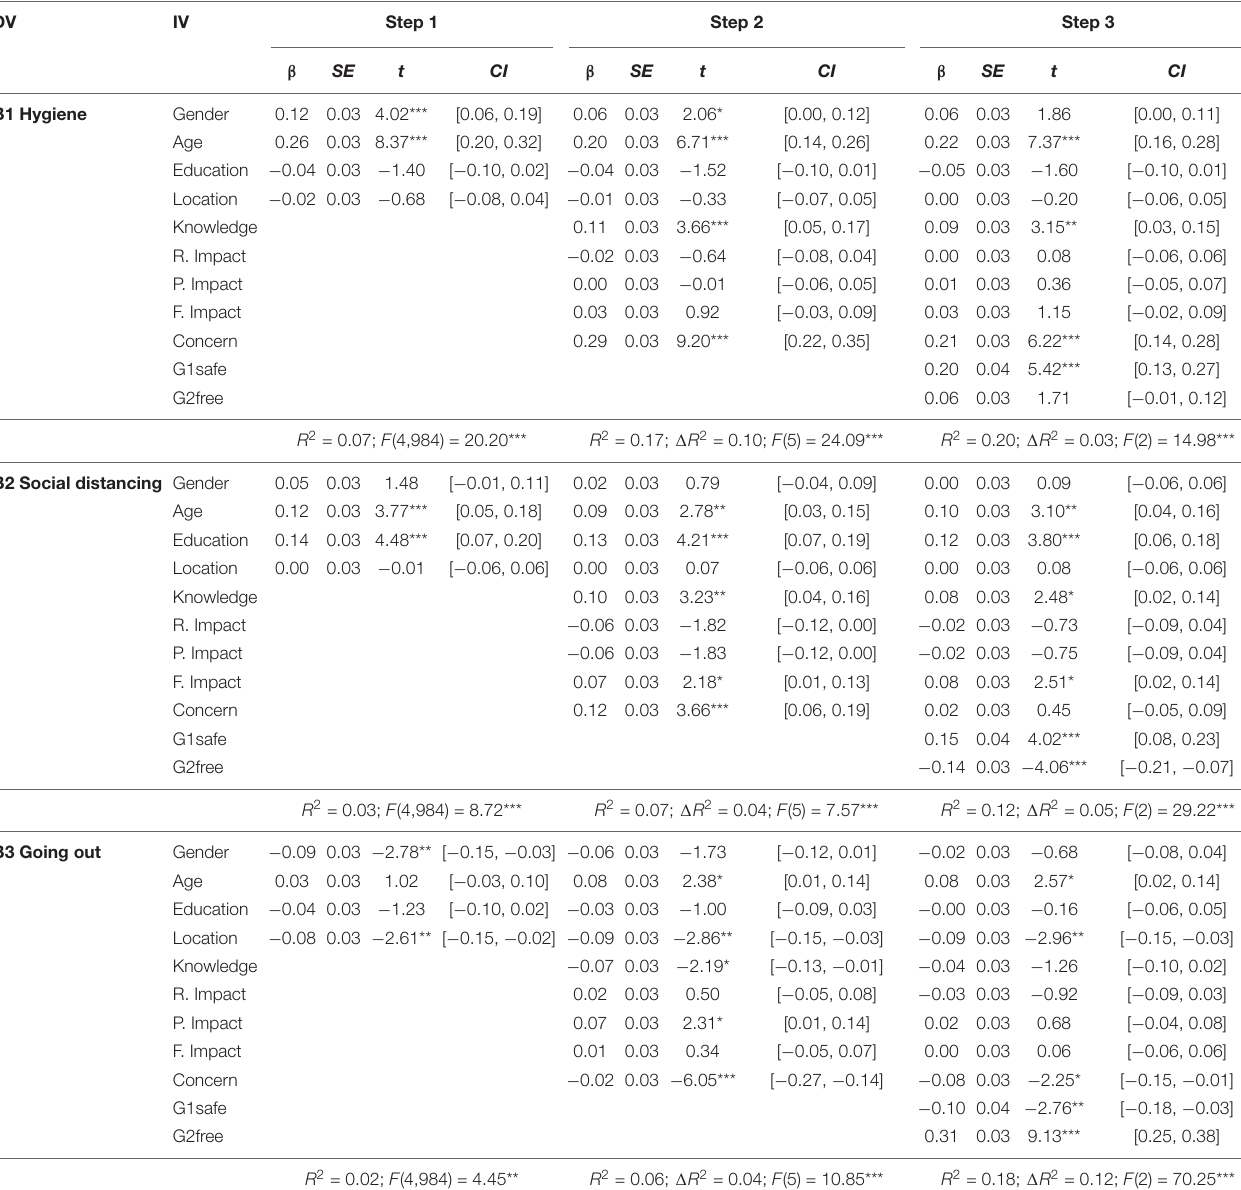
TABLE 7 | Predicting behaviors: Incremental effects of